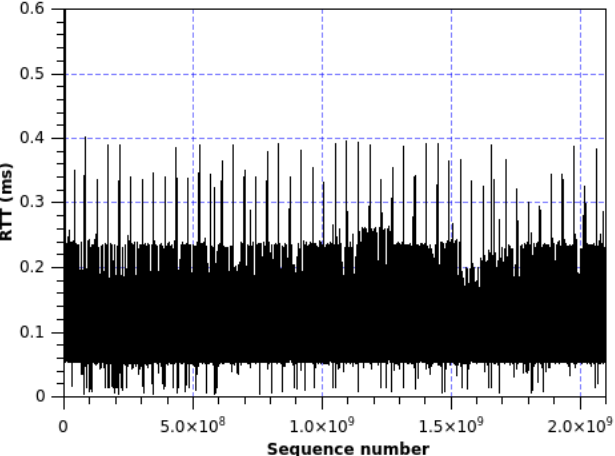
Figure 7. RTT deviation on router with an unmodified Linux kernel.